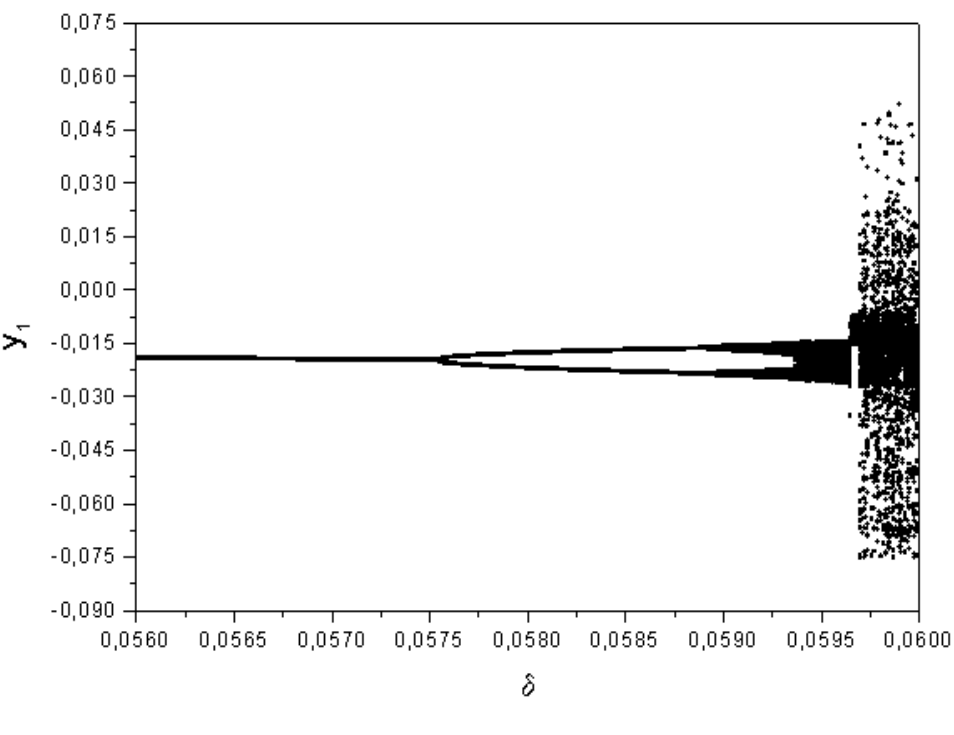
Fig. 3. Bifurcation diagram varying parameter δ with θ = 0 . 7 : 0 . 056 (cid:1) δ (cid:1) 0 . 06